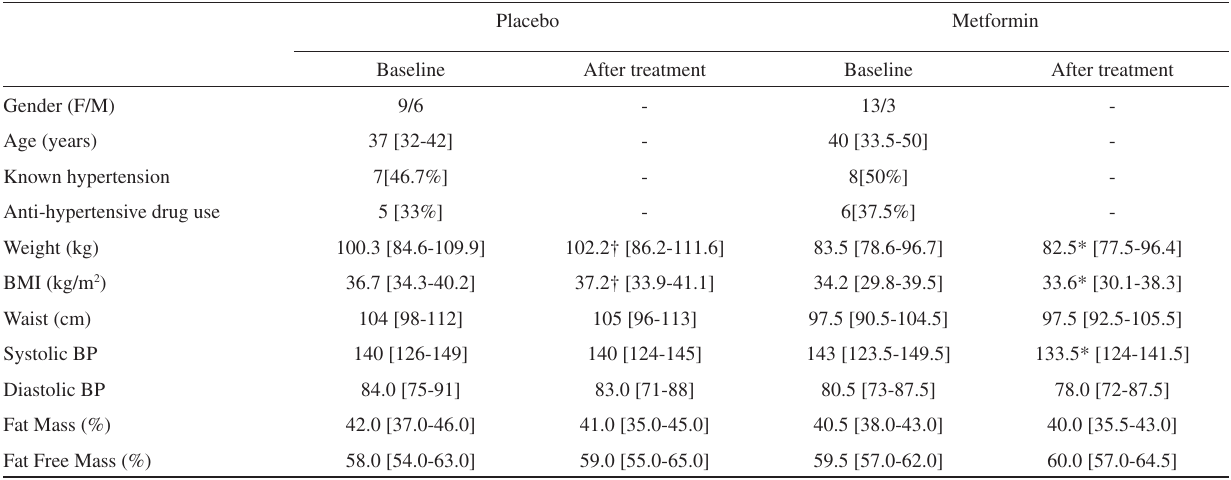
Table 1 - Clinical, anthropometric and body composition characteristics of both groups at baseline and after treatment